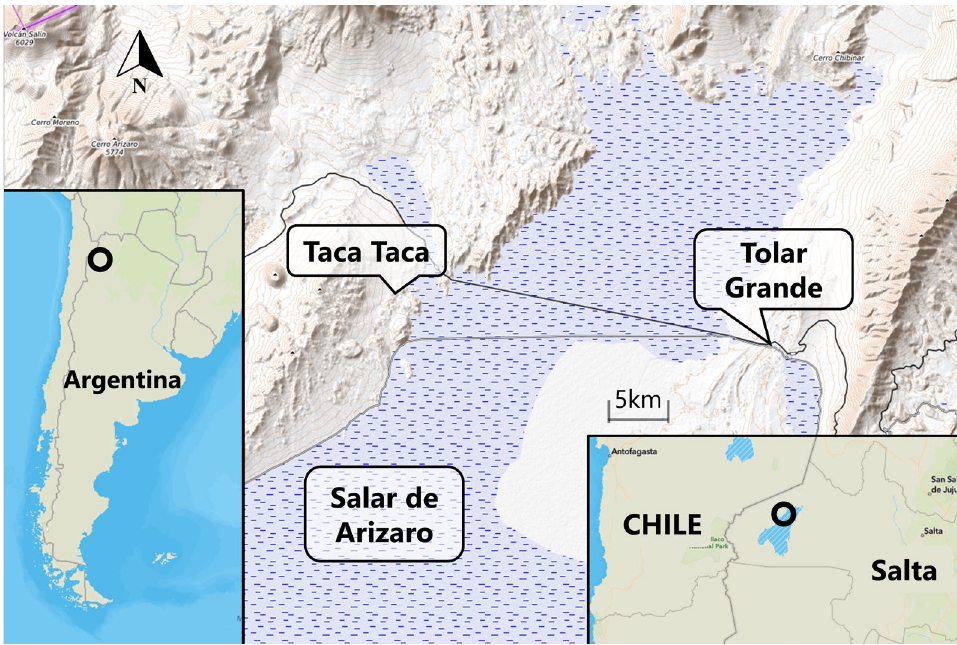
Figure 1. Location of Taca Taca mining project, Northwest Salta province, Argentina. The project (highlighted with black circles) is situated on the western side of Salar de Arizaro, 35 km away from the village of Tolar Grande.